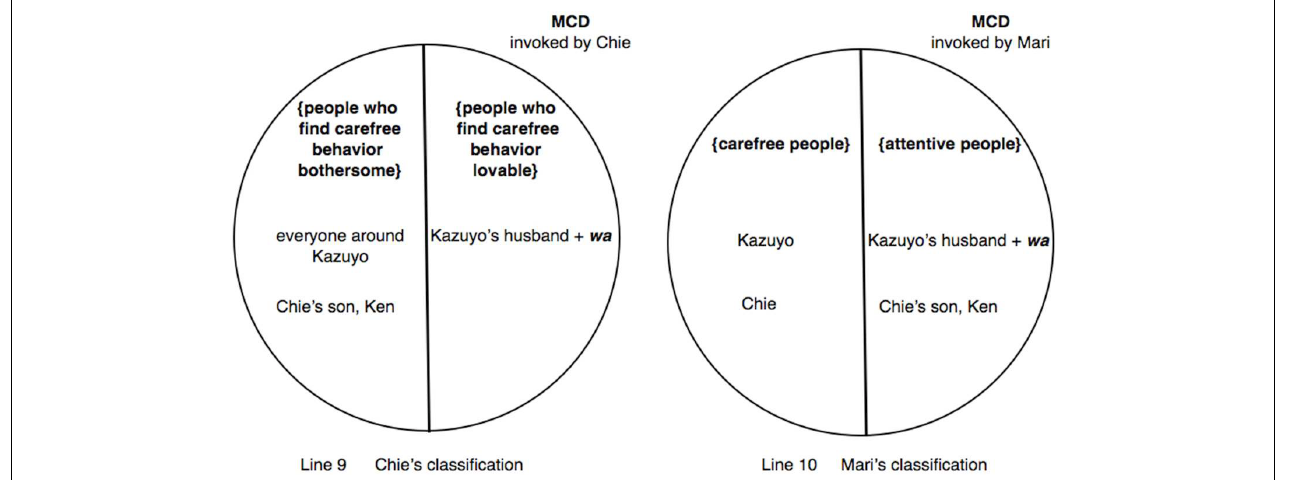
FIGURE 5 | Excerpt (8): Different MCDs triggered by Chie’s marking of “Kazuyo’s husband” with wa. Chie invokes the MCD partitioned by opposing reactions to carefree behavior {people who find carefree behavior